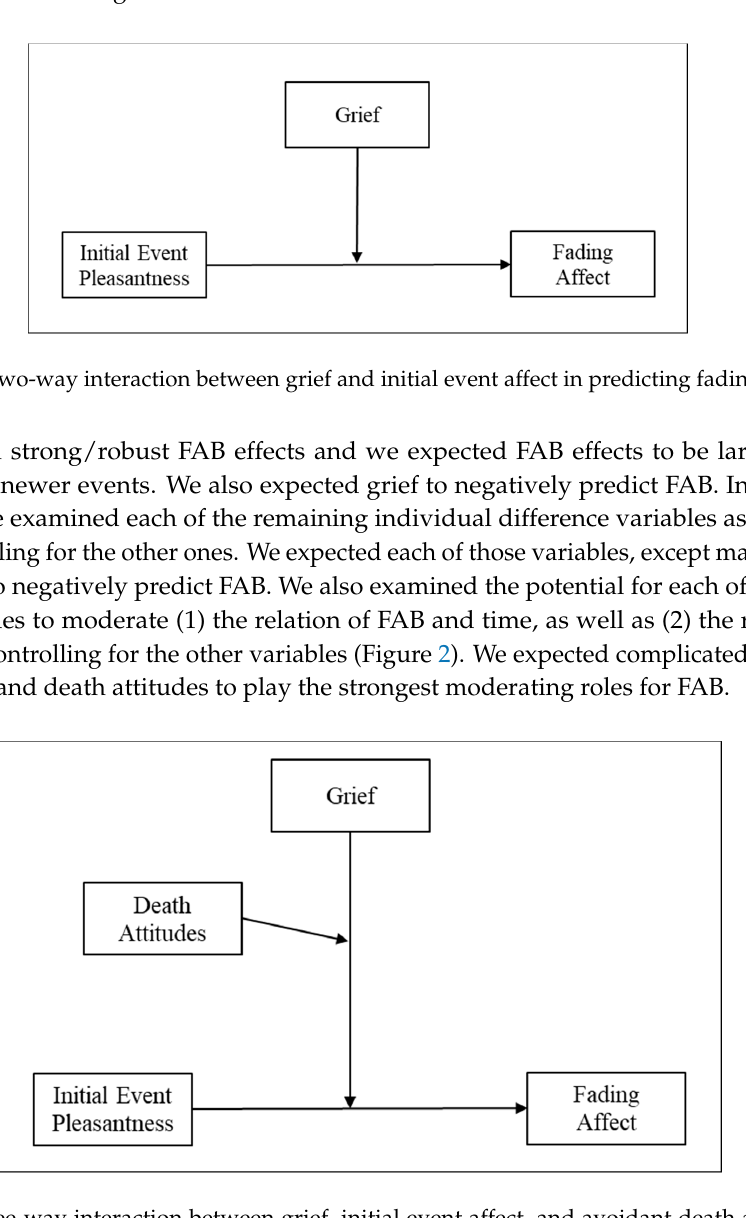
Figure 2. Three-way interaction between grief, initial event affect, and avoidant death attitudes in predicting fading affect.